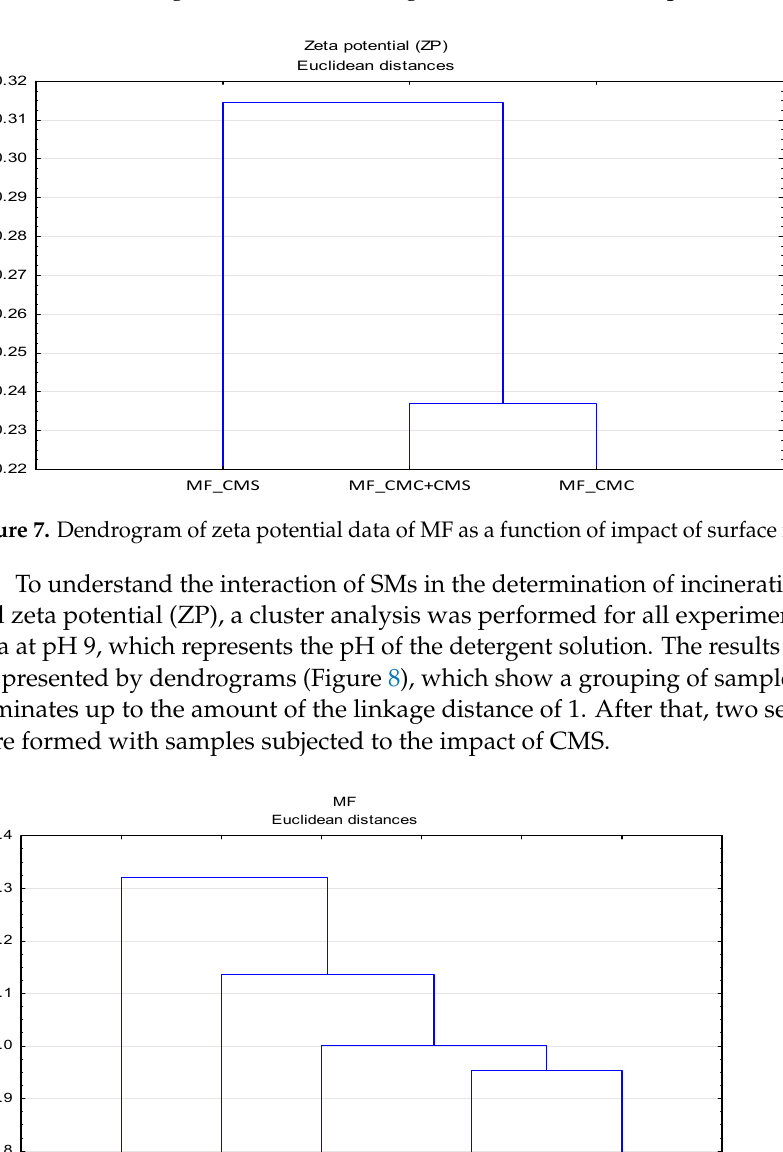
10 of 17 Figure 6. Zeta potential of cotton fabrics before and after 10 cycles of modification with detergent with CMC + CMS in hard and soft water at 40, 60 and 90 °C depending on the pH of 1 mmol/L KCl. The zeta potential curves are not grouped and are similar to the curves of fabrics modified by CMC, indicating a dominant impact of CMC over CMS in the CMC/CMS blend, which is shown by the grouping and lower surface charge of the modified cotton fabric. An interesting phenomenon in the modification of cotton fabric at 40 °C in hard water is reflected in the values of the zeta potential. The cotton fabric modified with CMC is more negative than the unmodified one, indicating a proper orientation of the -COOH polymer groups. A similar behavior is also observed by the modification with CMS. The specific orientation of the polymers, CMC and CMS, covered the cotton cellulose and pre-